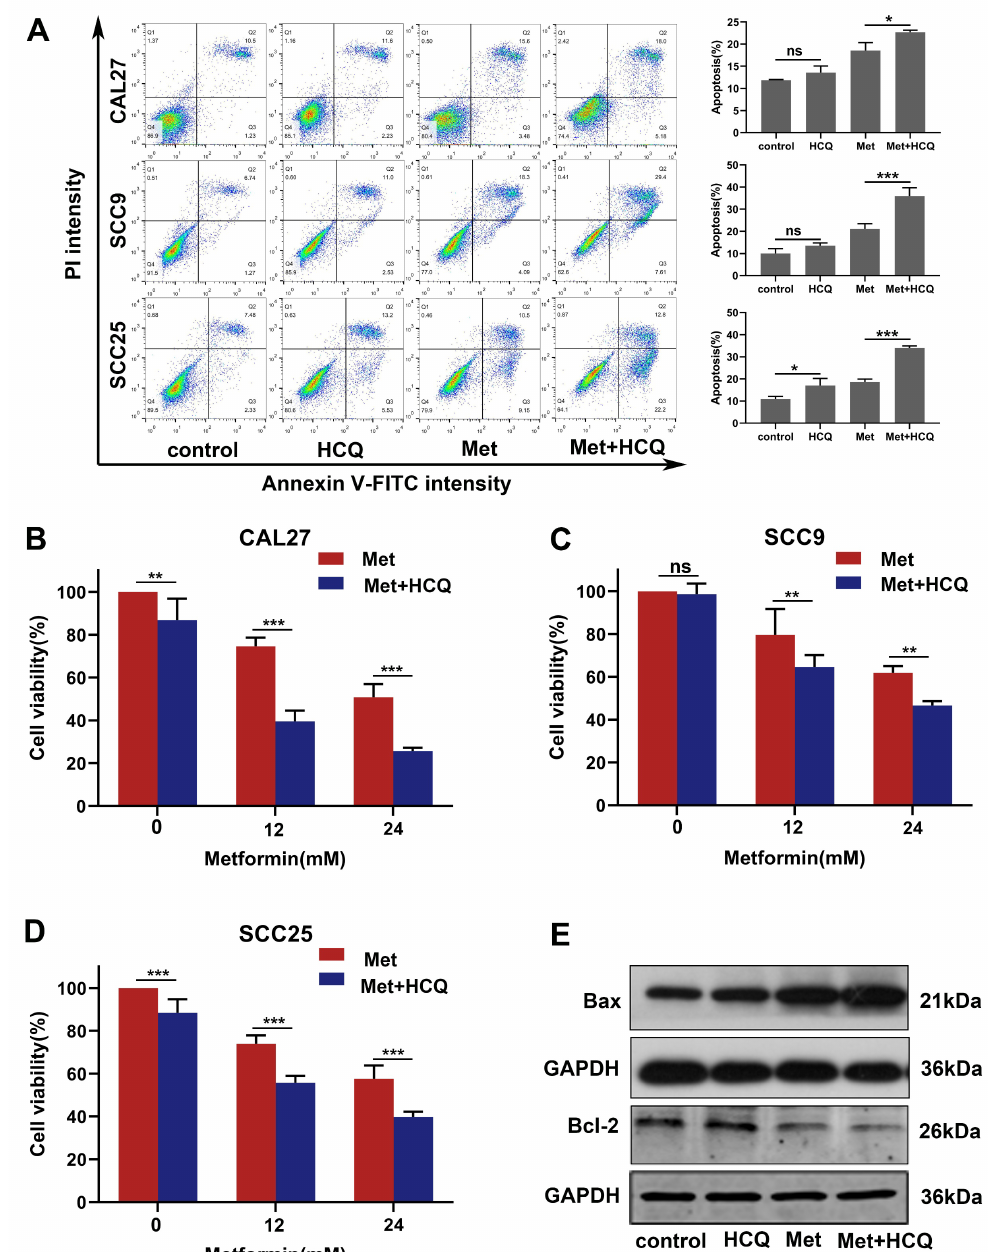
Figure 6. Inhibiting autophagy with HCQ increased the apoptosis of OSCC cells caused by metformin. ( A ) The OSCC cell lines (CAL27, SCC9, SCC25) were treated with metformin (12 mM), HCQ (20 µ M), and combined treatment (metformin and HCQ) for 48 h. Flow cytometry assays were performed to assess the apoptosis level in OSCC cells. ( B – D ) The OSCC cell lines were treated with various concentrations of metformin (0, 12, 24 mM), with or without HCQ (20 µ M), for 24 h. The cell viability was detected by CCK-8 assay. ( E ) CAL27 cells were treated as Figure 6A, and then the apoptosis related proteins were analyzed by western blot. Original blots see Supplementary Figure S4. GAPDH was used as the internal reference protein. The data are shown in the bar graph as mean ± SD. * p ≤ 0.05, ** p ≤ 0.01, *** p ≤ 0.001 and ns p > 0.05. Metformin group and HCQ group versus control group, metformin + HCQ group versus metformin